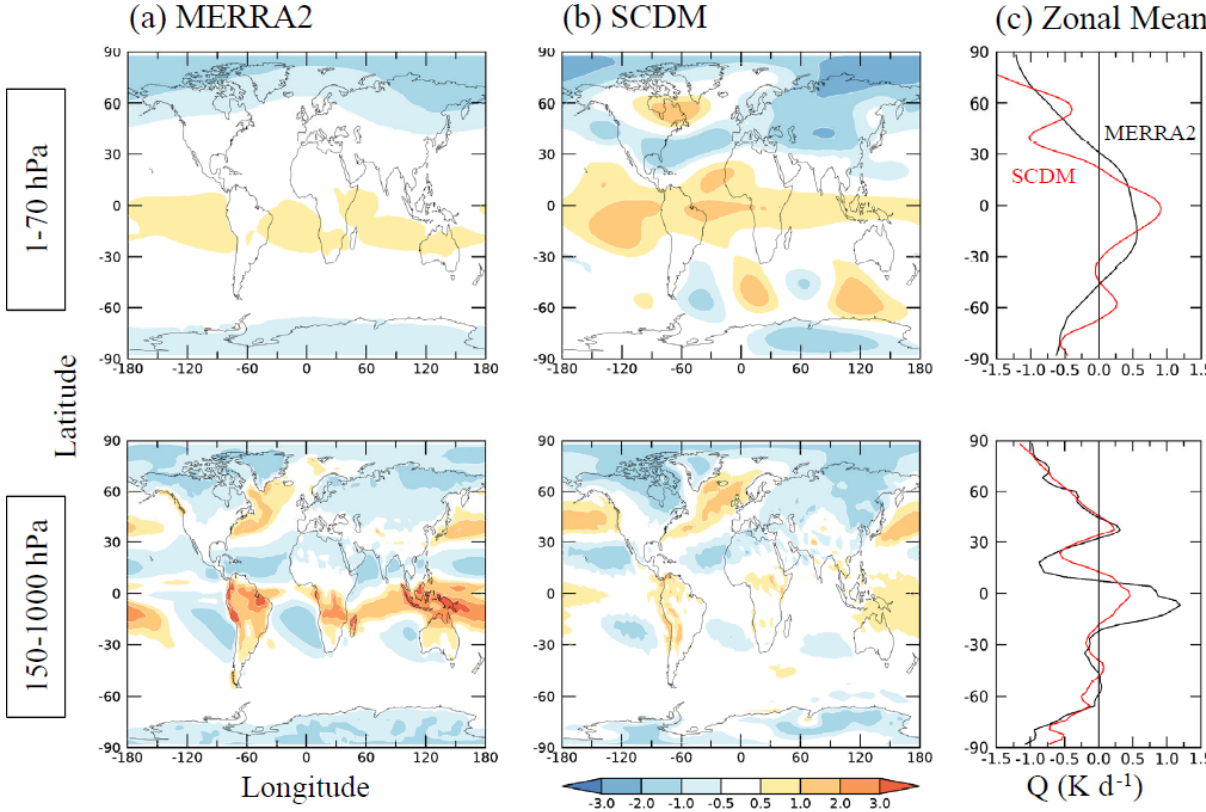
Figure 3. January–March diabatic heating rate Q clm (Kd − 1 ) for (a) MERRA2, (b) SCDM, and (c) zonal means of (a) and (b) . Shown are vertical averages over (top) the stratosphere (1–70hPa) and (bottom) the troposphere (150–1000hPa). The MERRA2 diabatic heating data are estimated from the temperature tendency due to